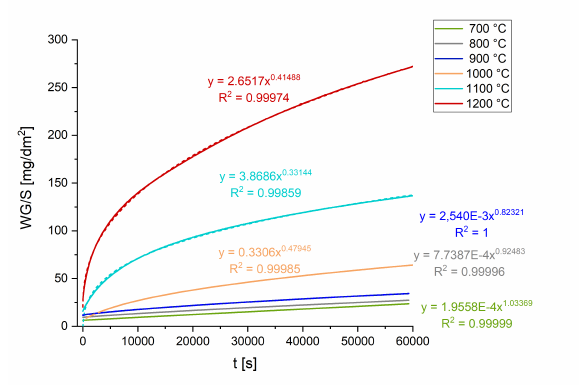
Figure 5. Oxidation kinetics of Cr-Ni at 700 °C, 800 °C, 900 °C, 1000 °C, 1100 °C and 1200 °C in steam. The dot curves indicate a fitting relationship between weight gain over an area unit and oxidation time of 20 hours